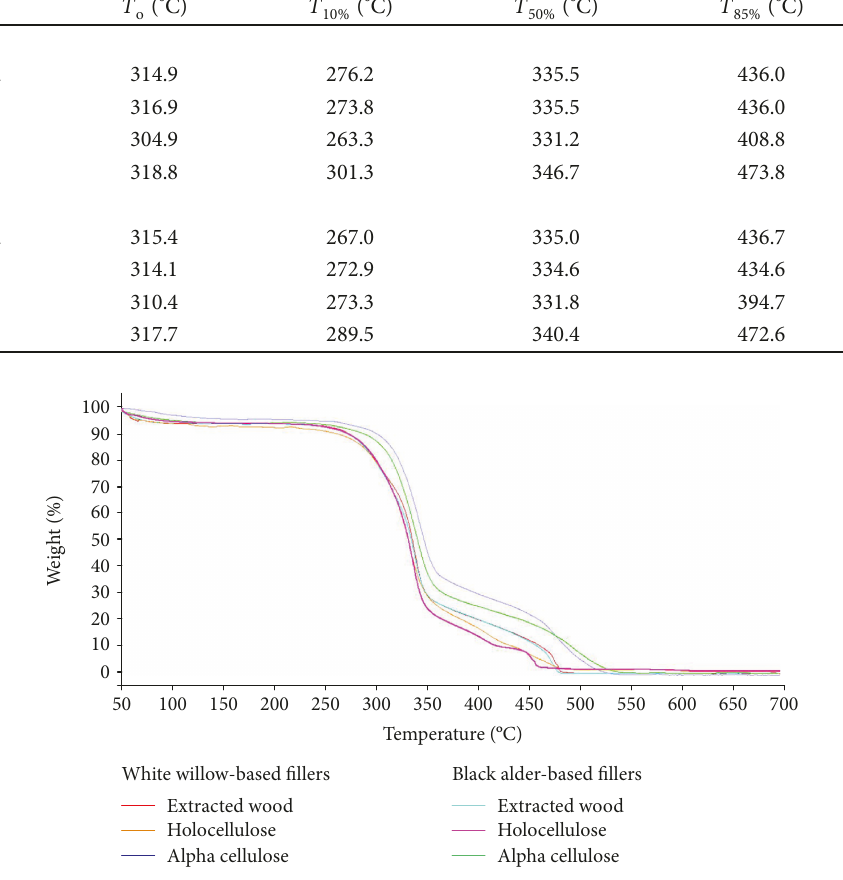
Figure 1: TG curves of wood fi